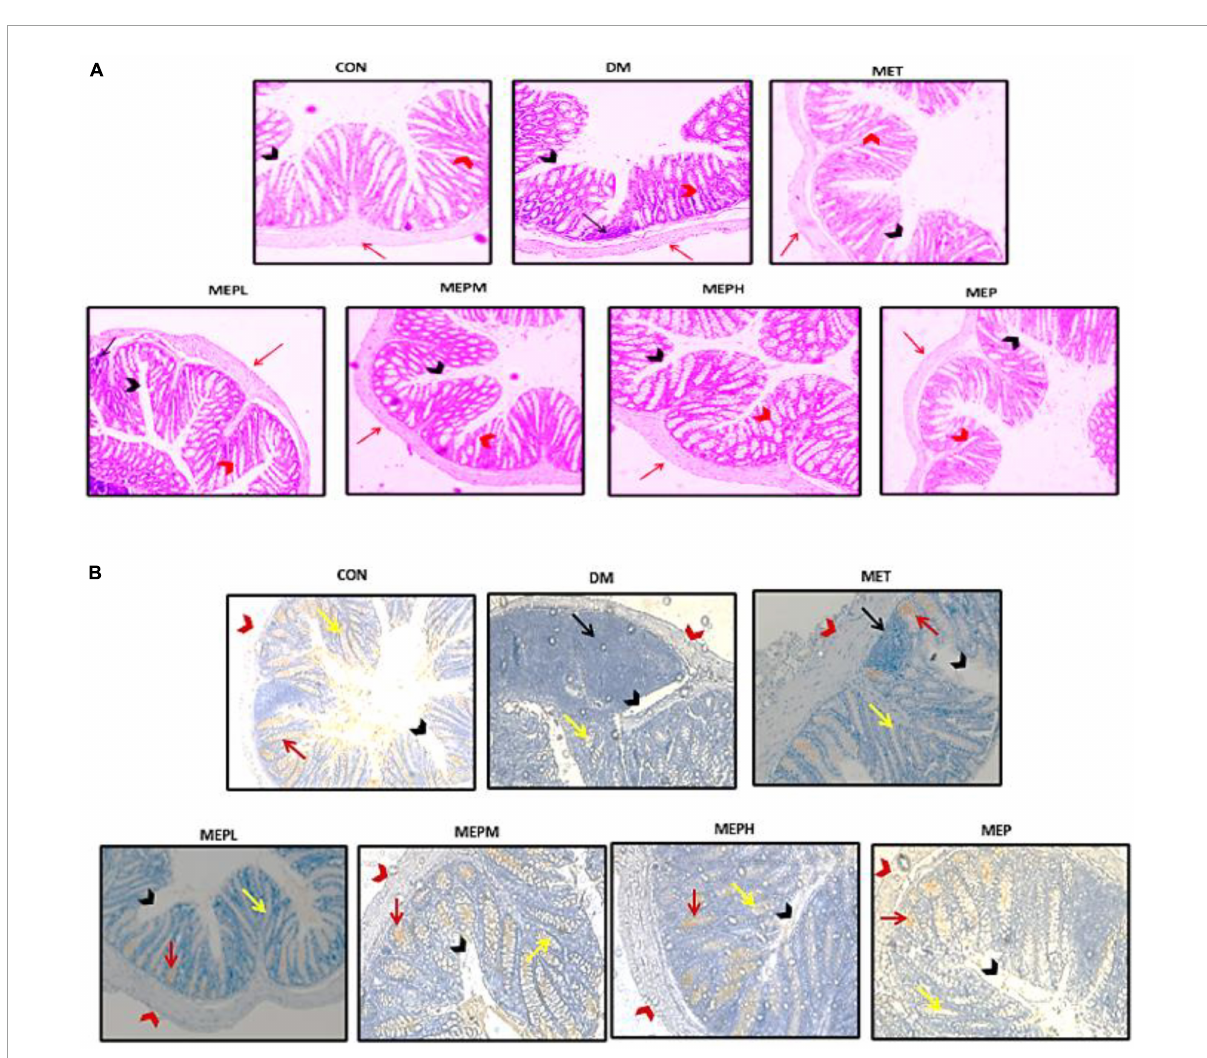
FIGURE9 Effect of MEP on colonic histological changes by H&E (haematoxylin and eosin) staining and (MUC2) expression by IHC (immunohistochemistry) staining in T2DM mice. (A) Photomicrographs of distal colonic tissue, the (black arrows) indicate inflammatory cells, (black arrowhead) indicate mucosal space, (red arrow) epithelium surface and (red arrowhead) epithelial and goblet cells at magnification 20 × . (B) Photomicrographs of the immunohistochemistry (red arrow) indicate MUC2 expression, (black arrows) indicated inflammatory cells, (black arrowhead) indicates mucosal space, (red arrows head) epithelium surface, and (yellow arrow) shows epithelial and goblet cells by the magnification of 20 ×